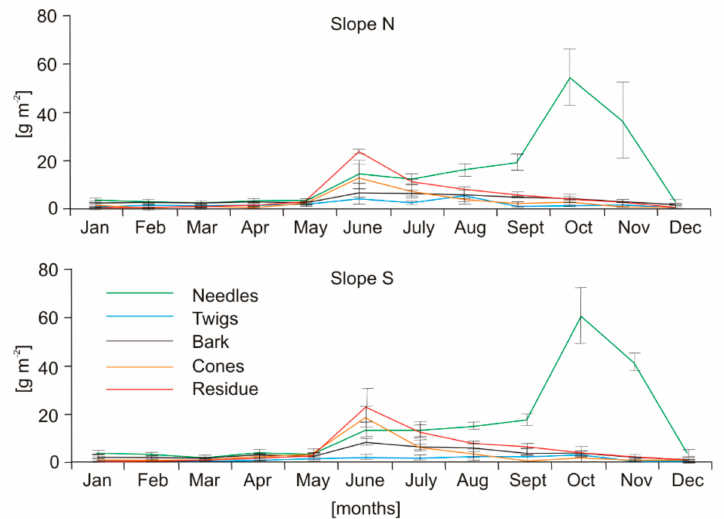
Figure 2. Averaged annual dynamics of mass of the investigated litterfall categories on slopes N and S (averaged for the three study